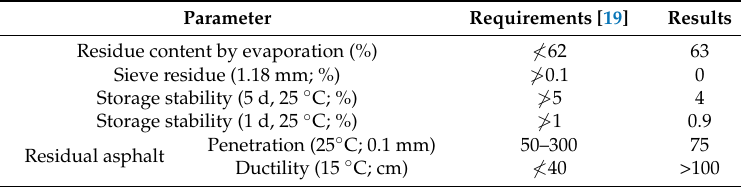
Table 2. Properties of emulsified